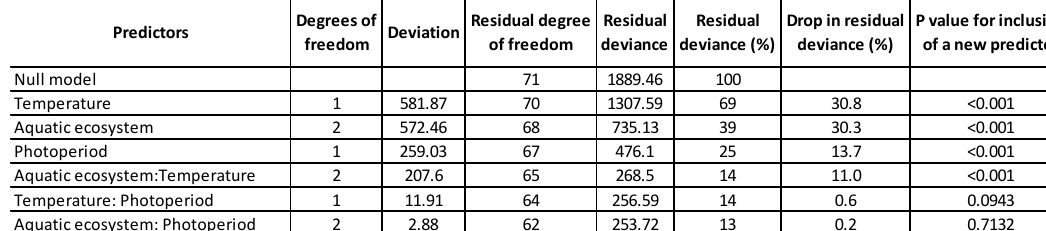
Analysis of the residual deviation for each of the assessed predictors Degrees of Residual degree Predictors Deviation freedom of